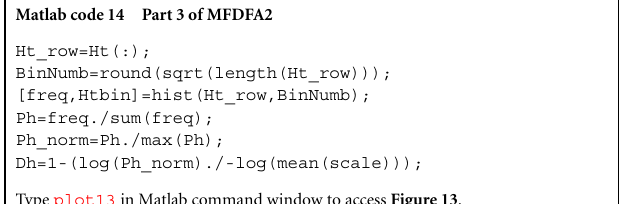
FIGURE 13 | (A) The multifractal , monofractal, and whitenoise time series (upper panel) and their local Hurst exponents Ht(:,5) computed by Matlab code 13 (lower panel).The multifractal time series have a larger variation in the local Hurst exponents Ht(5,:) compared with the monofractal and whitenoise time series.The period with the local fluctuation of the smallest magnitude in multifractal time series contains the maximum Ht(5,:) (see Ht max in period between the black dashed lines ) whereas the period with the local fluctuation of the largest magnitudes